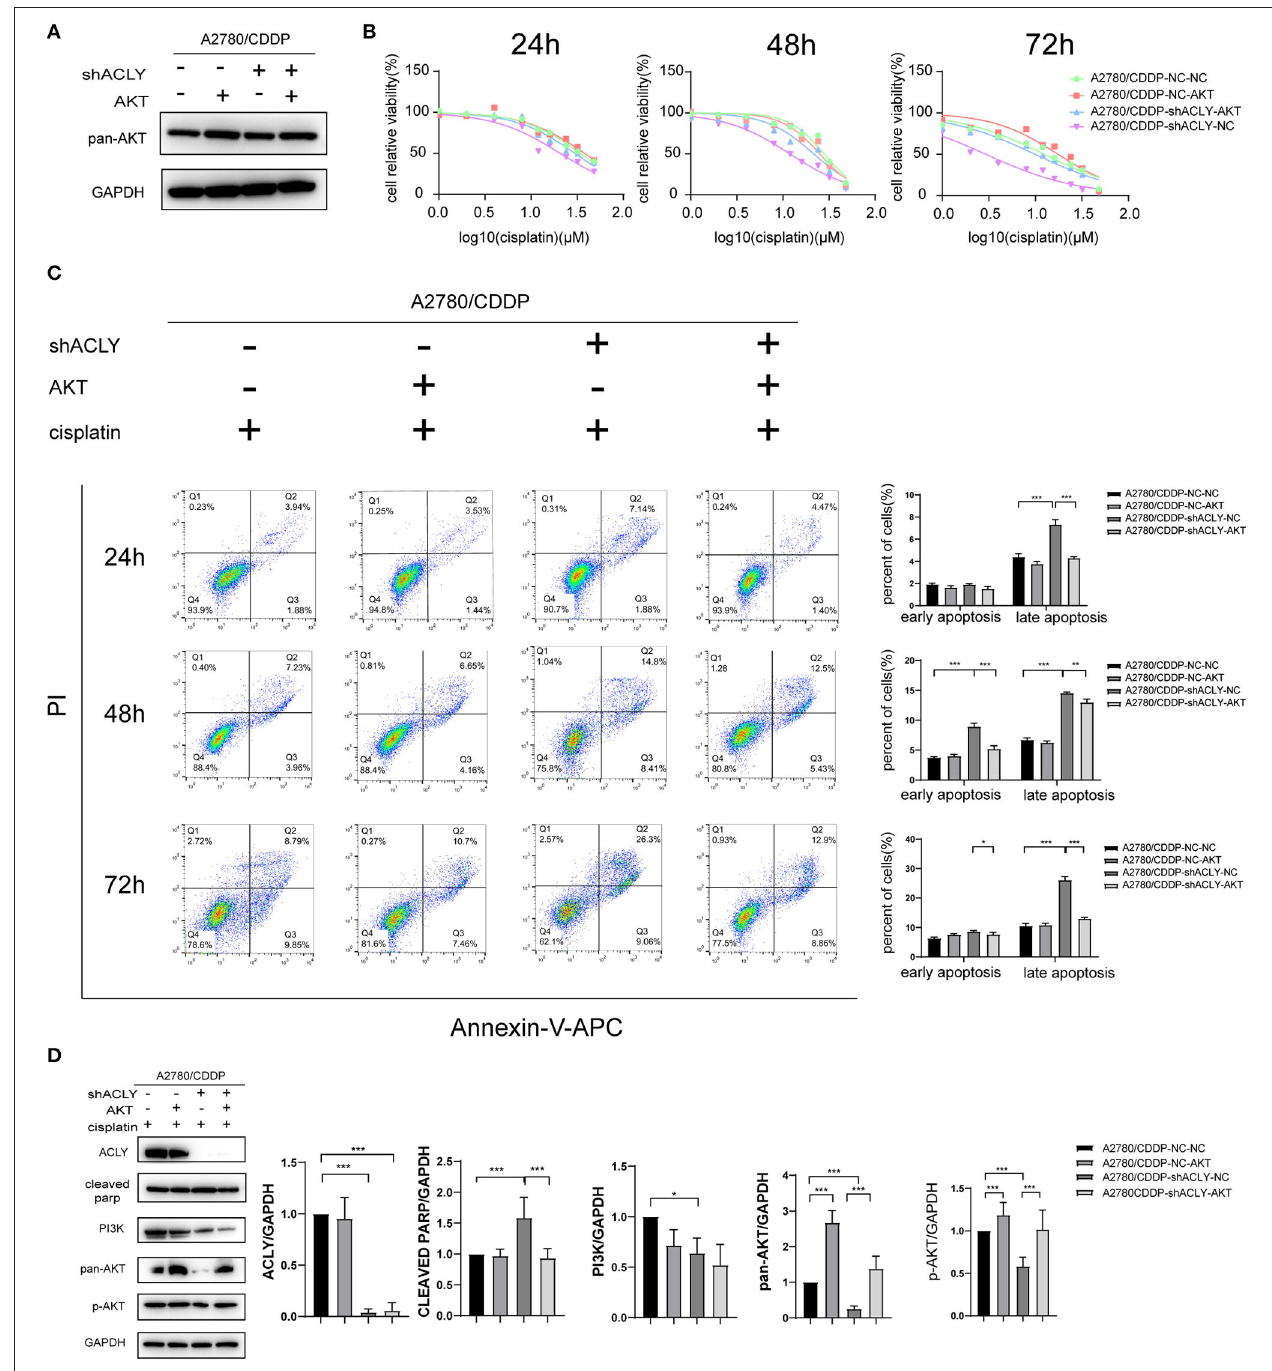
FIGURE 6 | Overexpression of AKT increased resistance of A2780/CDDP-shACLY cells to cisplatin. (A) Western blotting was used to confirm the effectiveness of AKT overexpression by plasmid in A2780/CDDP-NC and A2780/CDDP-shACLY cells. (B) The 24h IC50 of cisplatin of A2780/CDDP-NC-NC, A2780/CDDP-NC-AKT, A2780/CDDP-shACLY-NC and A2780/CDDP-shACLY-AKT was 34.33 (33.04–35.74), 38.06 (34.39–42.95), 20.72 (18.83–22.90), and 29.86 (27.38–32.86) µ M, respectively; 48h IC50 of these cells were 27.90 (25.78–30.21), 25.06 (23.07–27.22), 11.86 (11.06–12.70), and 21.56 (18.96–24.44) µ M, respectively; 72h IC50 of these cells were 12.46 (10.88–14.21), 14.26 (12.85–16.74), 2.933 (2.552–3.340), and 9.891 (8.613–11.29) µ M, respectively. (C) Apoptosis analysis on A2780/CDDP-NC-NC, A2780/CDDP-NC-AKT, A2780/CDDP-shACLY-NC, and A2780/CDDP-shACLY-AKT cells with the treatment of 20 µ M cisplatin on different time. Quantitive analysis of apoptotic ratio by flowjo V10 software. Statistical analysis was performed using Student’s t -test. (D) Western blotting was used to detect the expression of PI3K/AKT relative proteins of A2780/CDDP-NC-NC, A2780/CDDP-NC-AKT, A2780/CDDP-shACLY-NC, and A2780/CDDP-shACLY-AKT cells treated with 20 µ M cisplatin for 48h, the bands were quantified and analyzed. The bands were quantitated with Image J software, statistical analysis was performed using Student’s t -test. All cell experiments were repeated three times at least. * P < 0.05, ** P < 0.01, and *** P < 0.001 for statistical analysis of the indicated groups.